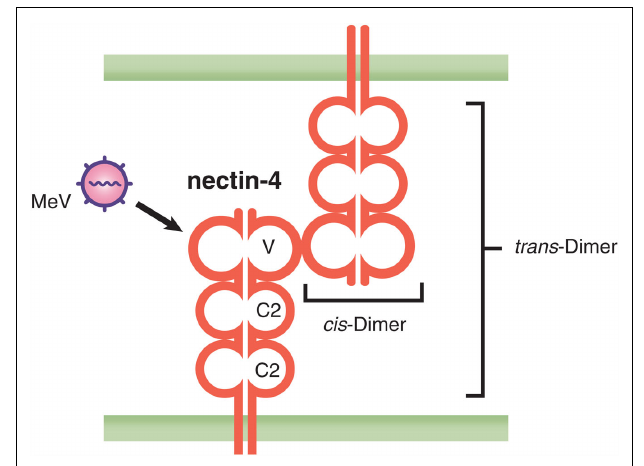
FIGURE 4 | Structure of nectins. The nectin family proteins contain three Ig-like loops (V and two C2-type domains) in their extracellular domain.Two nectin and nectin-like molecules of the same plasma membrane first form cis -dimers, and then this is followed by the formation of a trans -interaction between the Ig-like loops of cis -dimers located on opposing cells. MeV binds to theV domain of nectin-4,